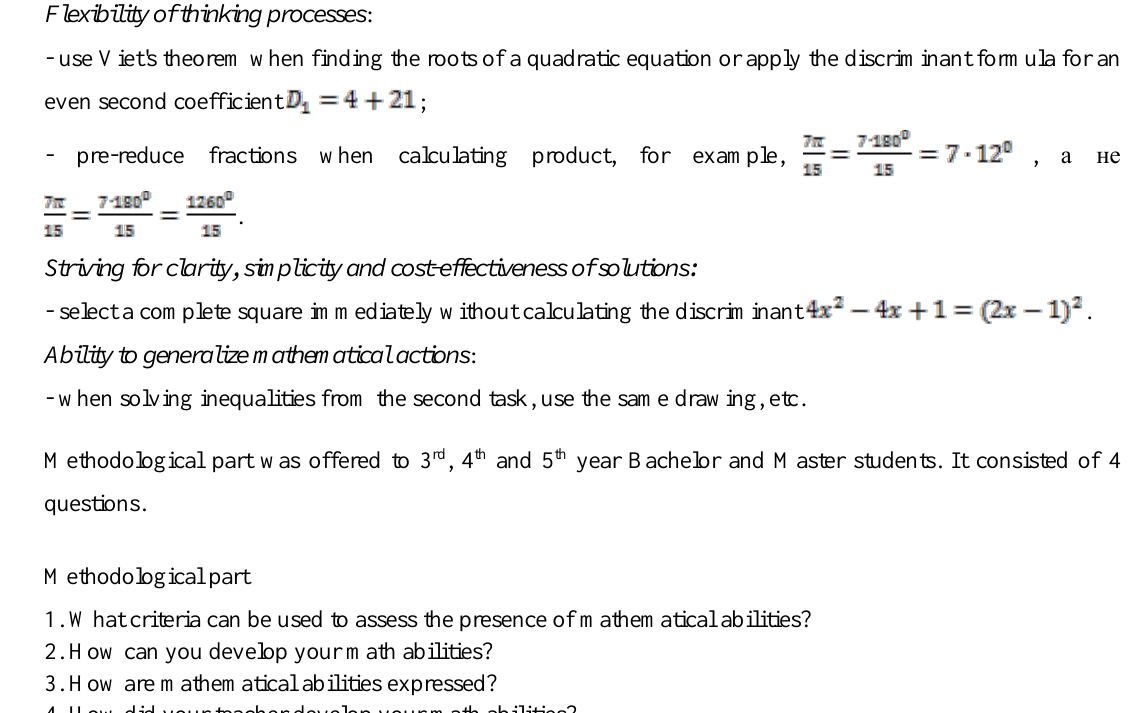
Table 2. Results of the mathematical part of the